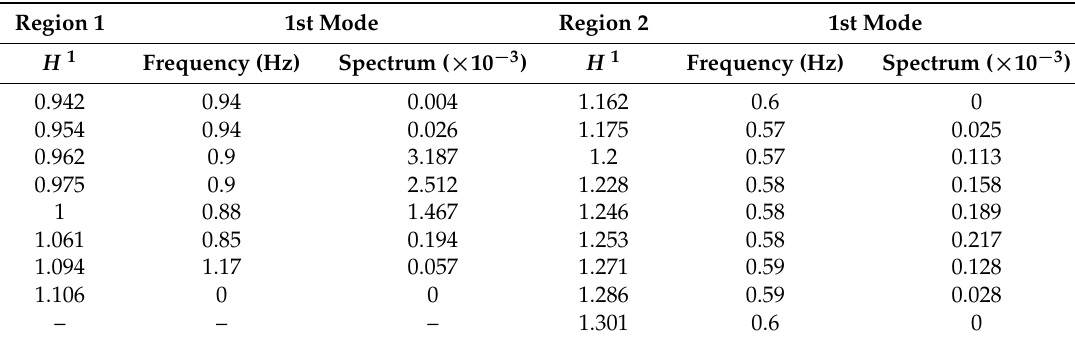
Table 2. Power spectral density with water level (exp.) for case